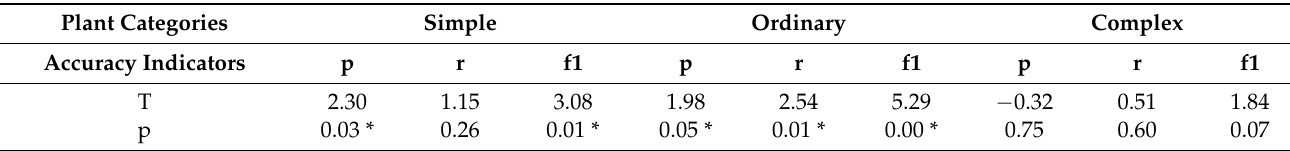
Table 4. The t-test of precision, recall, and F1-Score values of segmented overlapping leaves by SBF and K-means clustering algorithm.